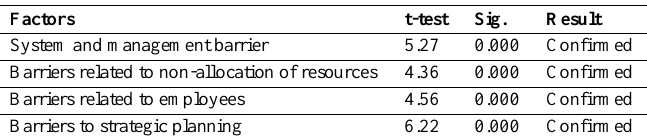
Table 4 . One-sample